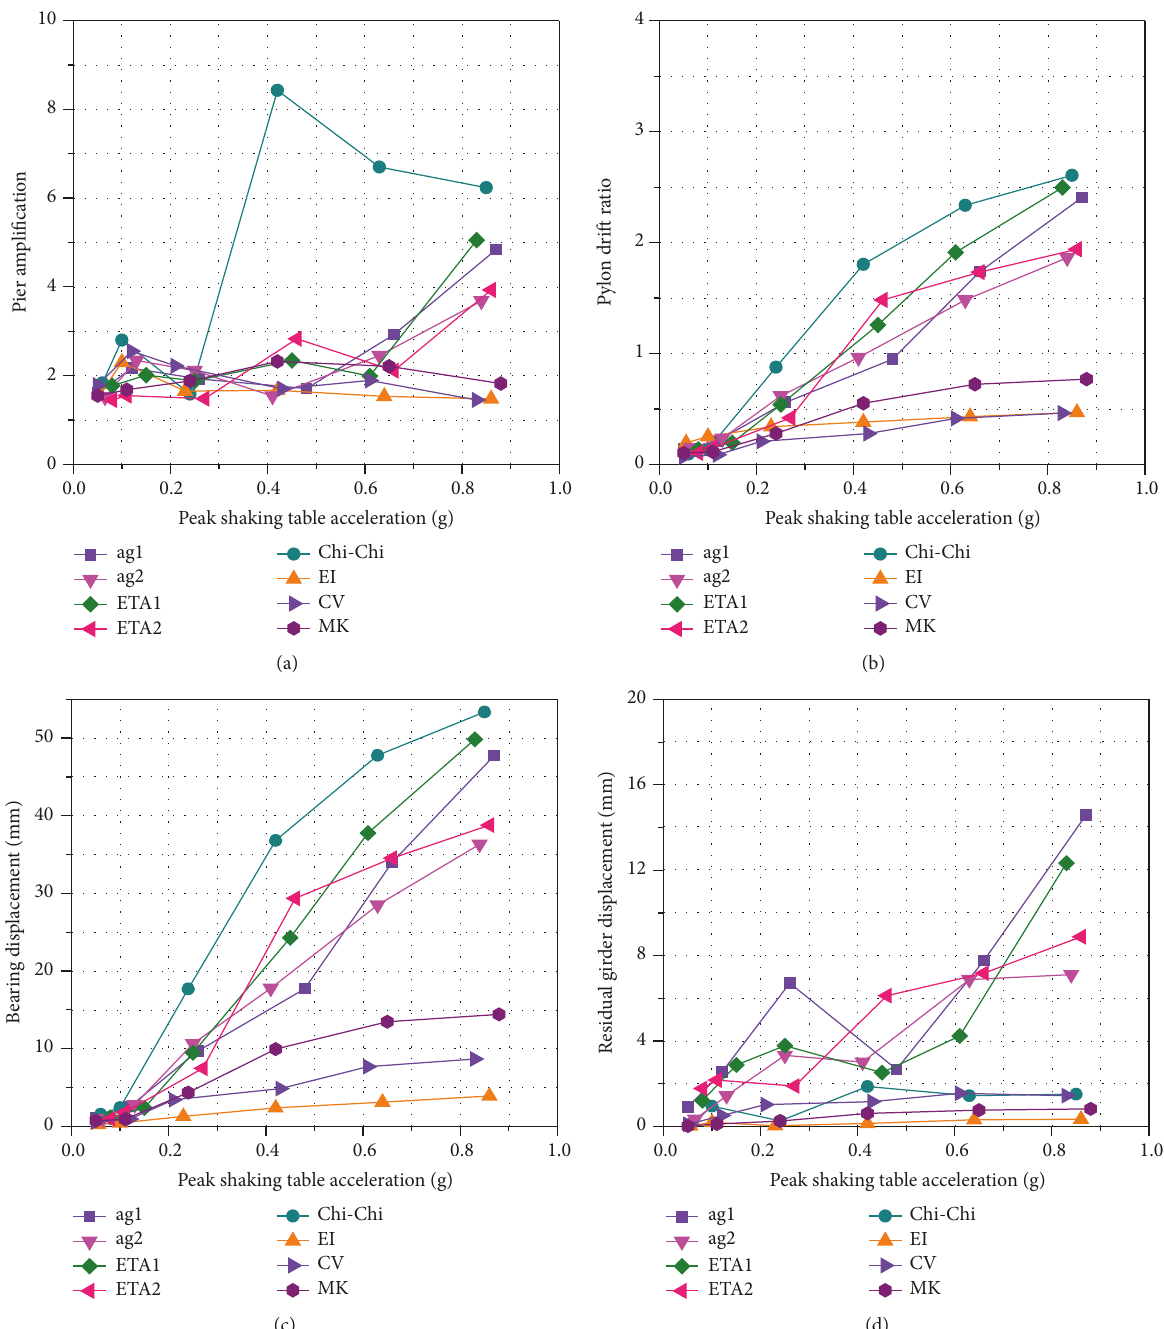
Figure 9: Maximum responses of four components: (a) pier acceleration; (b) pylon drift; (c) bearing displacement; and (d) deck